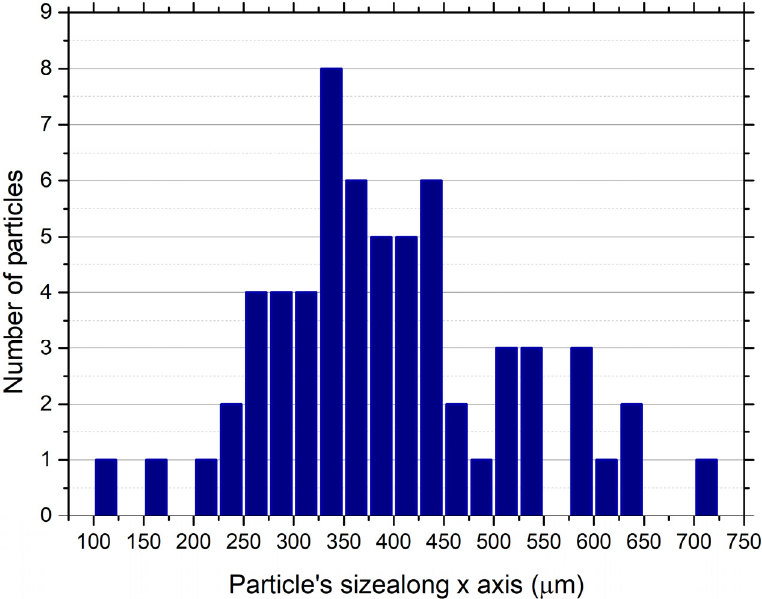
Figure 4. Size histogram of ice particles obtained from a series of interferograms: number of particles versus the x -axis particle’s size range.